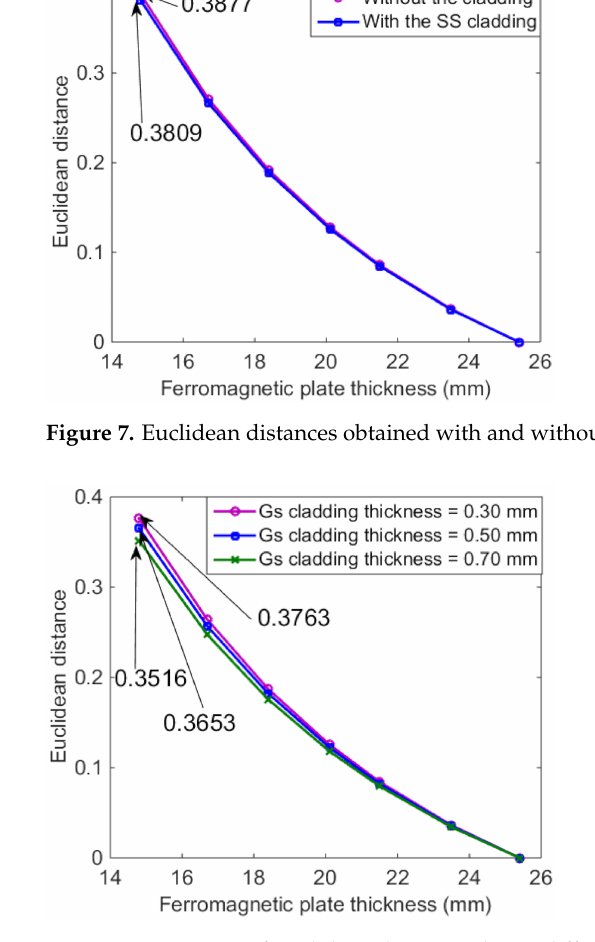
Figure 8. Variations of Euclidean distances due to different GS cladding